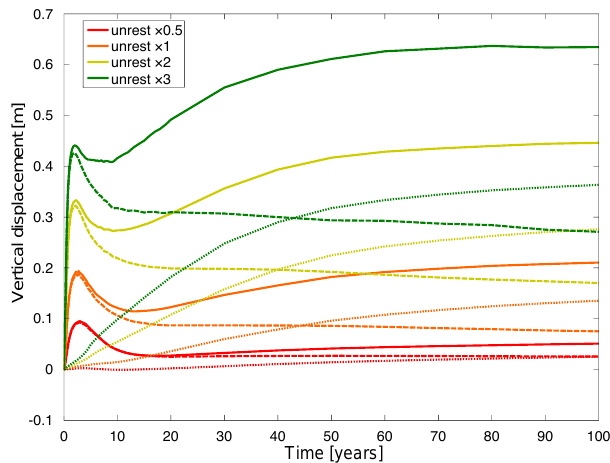
Figure 8. Computed vertical deformation at the centre of the model (r = 0 ,z = 0 ) over 100 years of unrest for Scenario I with different injection rates (see Table 4). The solid line is the total vertical dis- placement v = v P + v T , while the dashed and dotted lines are the vertical displacement due to pore pressure v P and thermal effects v T ,